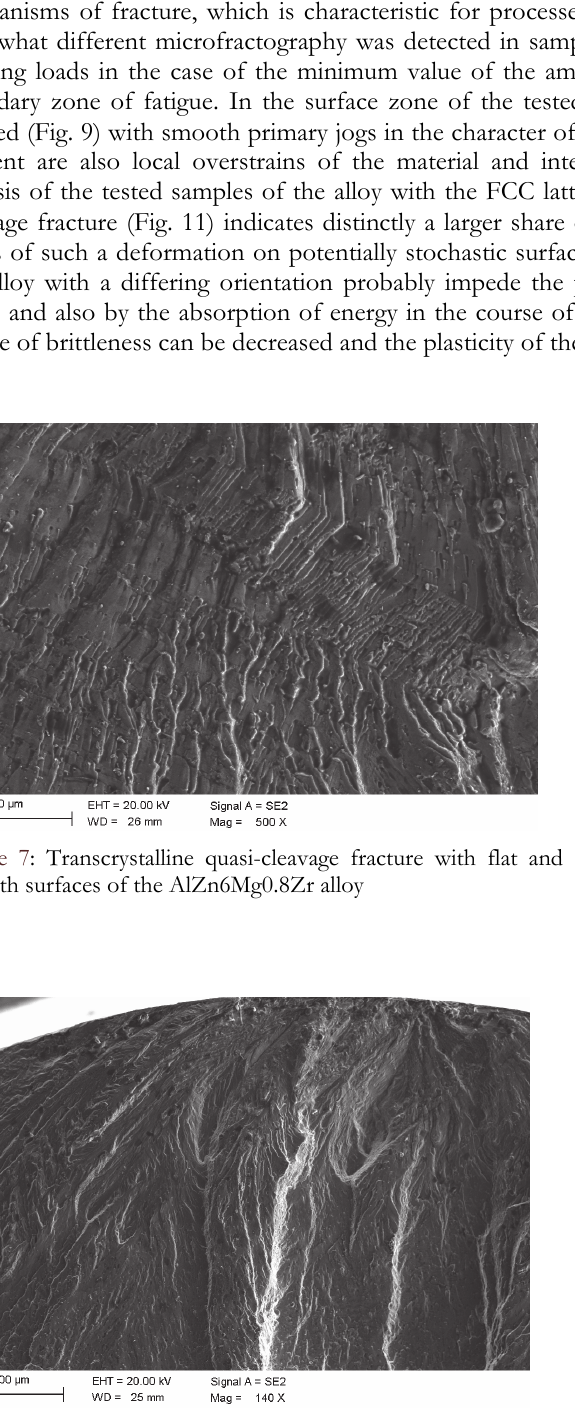
Figure 9: Symmetric focal points of a fracture in the surface zone with primary jogs of the investigated alloy.